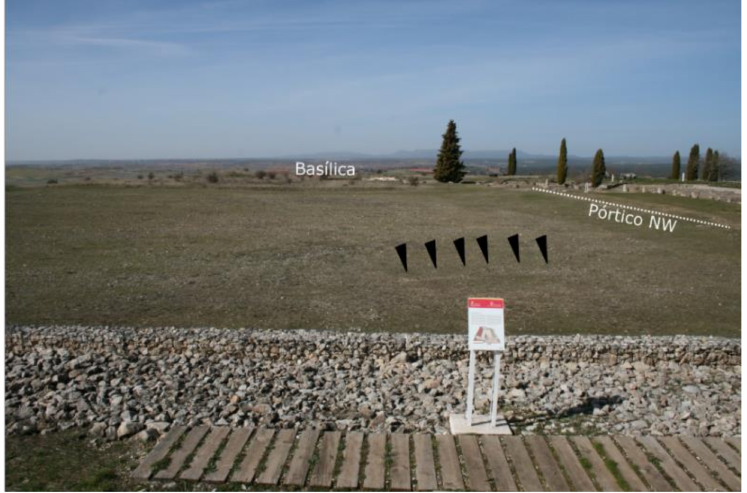
Figure 10. View of the forum from the temple. Arrows in black indicate an apparent alignment in front of the